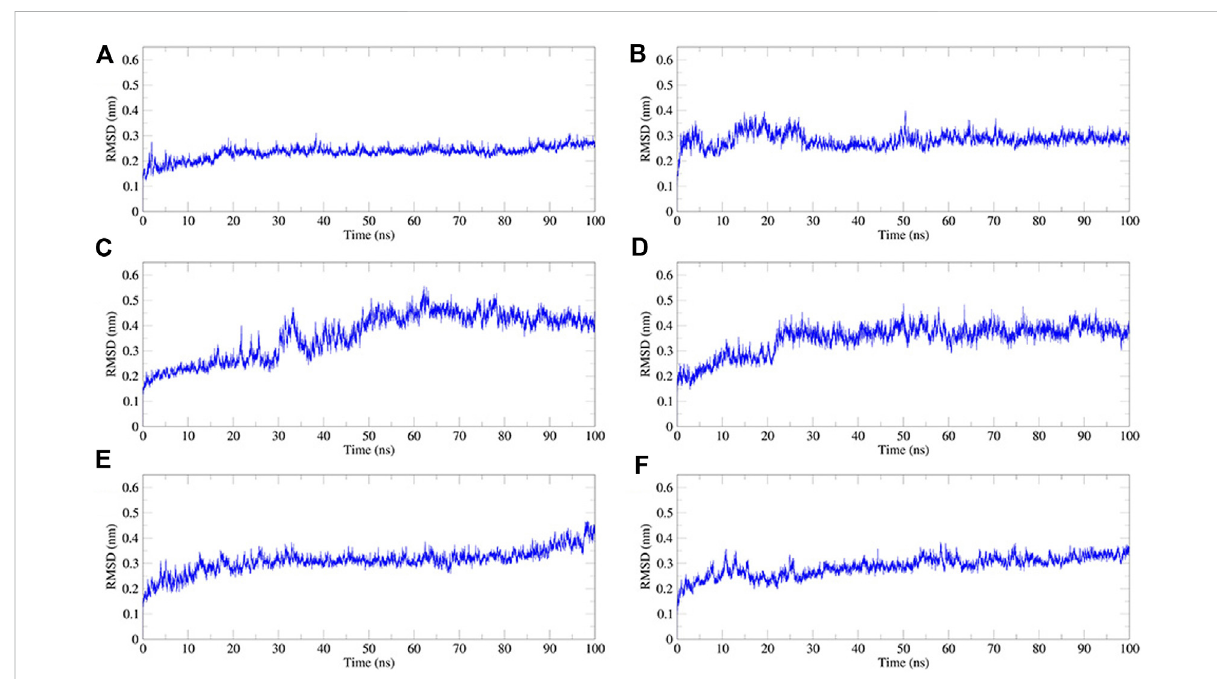
FIGURE 11 Plot of root mean square deviation (RMSD) values, during 100 ns MD simulation of compound – M pro complexes. (A) N3 – M pro RMSD; (B) N-1H- indazol-5-yl-2-(6-methylpyridin-2-yl)quinazolin-4-amine – M pro RMSD; (C) phthalocyanine – M pro RMSD; (D) antrafenine – -M pro RMSD (E) ergotamine – M pro RMSD; and (F) dihydroergotamine – M pro